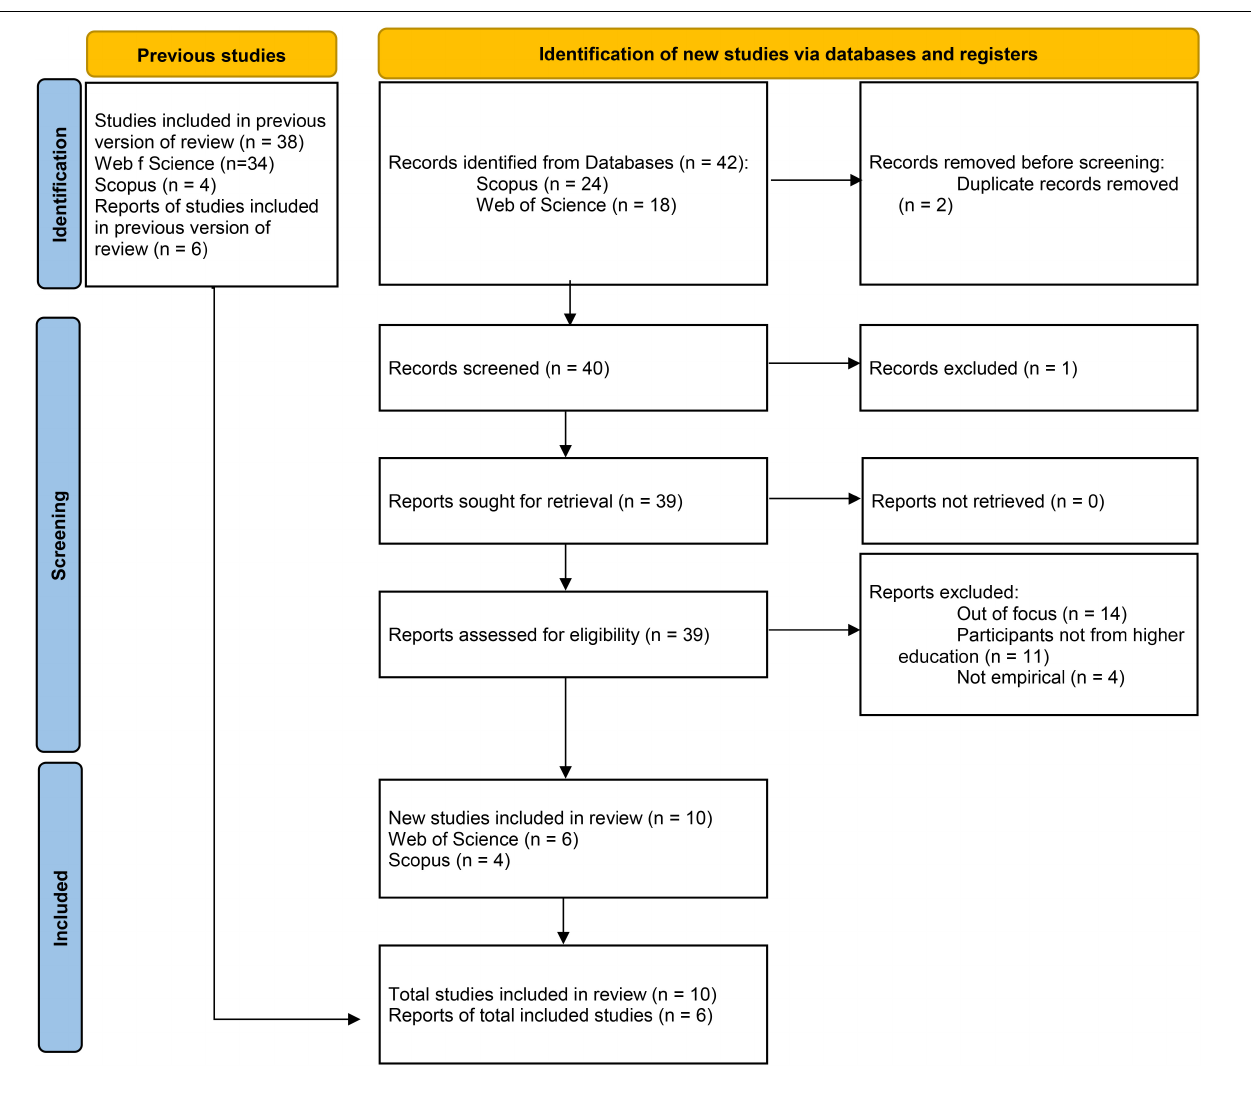
FIGURE 1 | Preferred reporting items for this